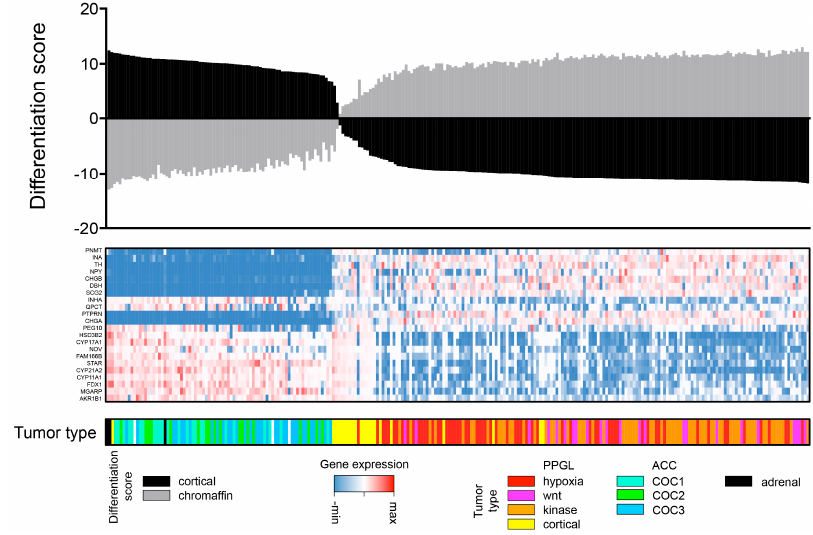
Figure 2. Chromaffin and cortical cell differentiation. Cortical and chromaffin cell differentiation of adrenocortical carcinoma (ACC), pheochromocytoma and paraganglioma (PPGL) and adrenal gland samples. Each column represents a unique sample that was ordered according to cortical cell differentiation. From above: differentiation scores for adrenal cortex (black) and adrenal medulla (grey). Middle; heatmap with expression values of genes representing chromaffin cells (upper half) and cortical cells (bottom half). Bottom: annotation of sample type accordingly to PPGL and ACC molecular subtypes. COC, Cluster of Clusters; Cortical, Cortical Admixture PPGL; Hypoxia, Pseudohypoxic PPGL; Kinase; Kinase signaling PPGL and Wnt, wnt-altered PPGL.